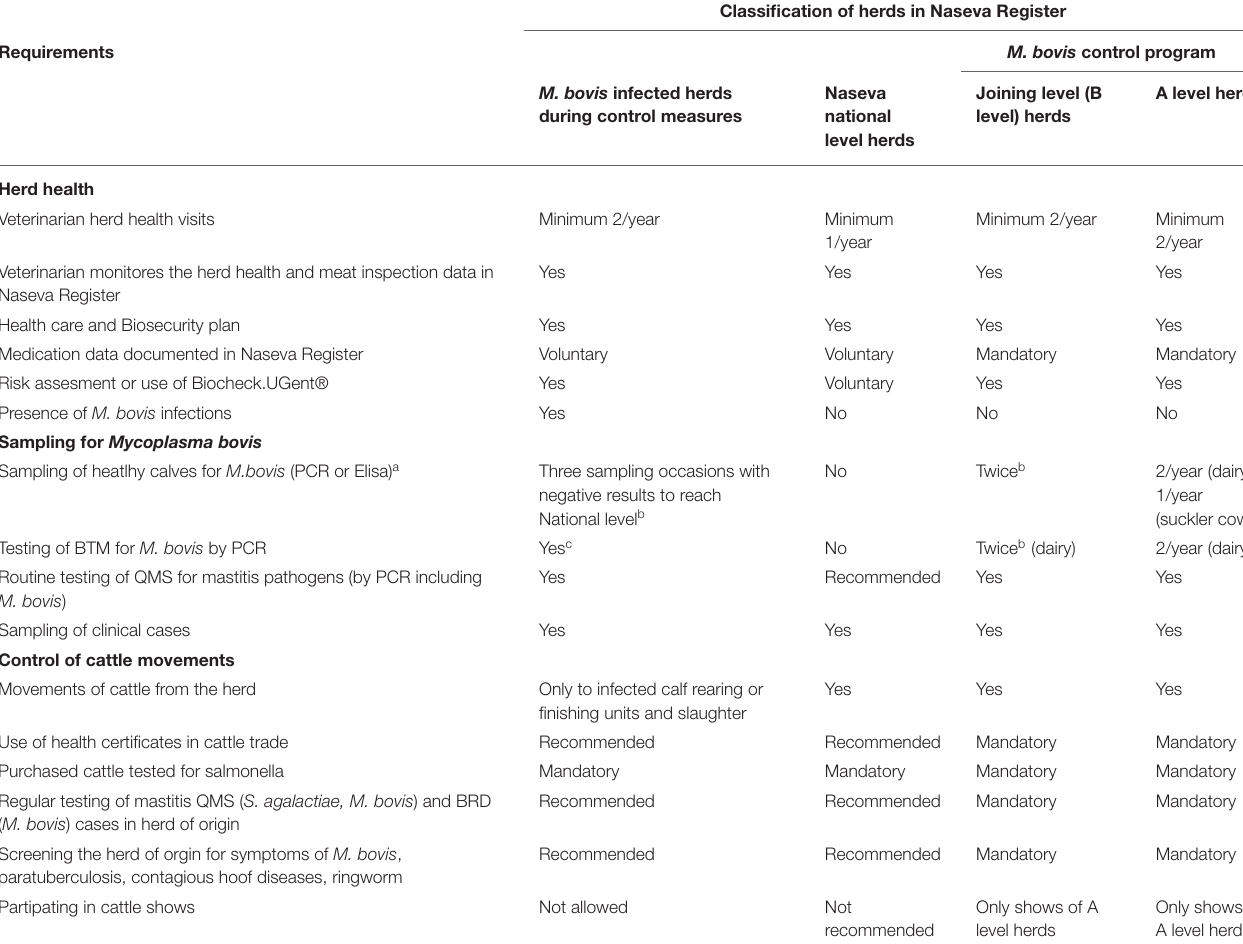
TABLE 3 | Classification of Finnish dairy and suckler cow herds in the Naseva register and in the M. bovis control